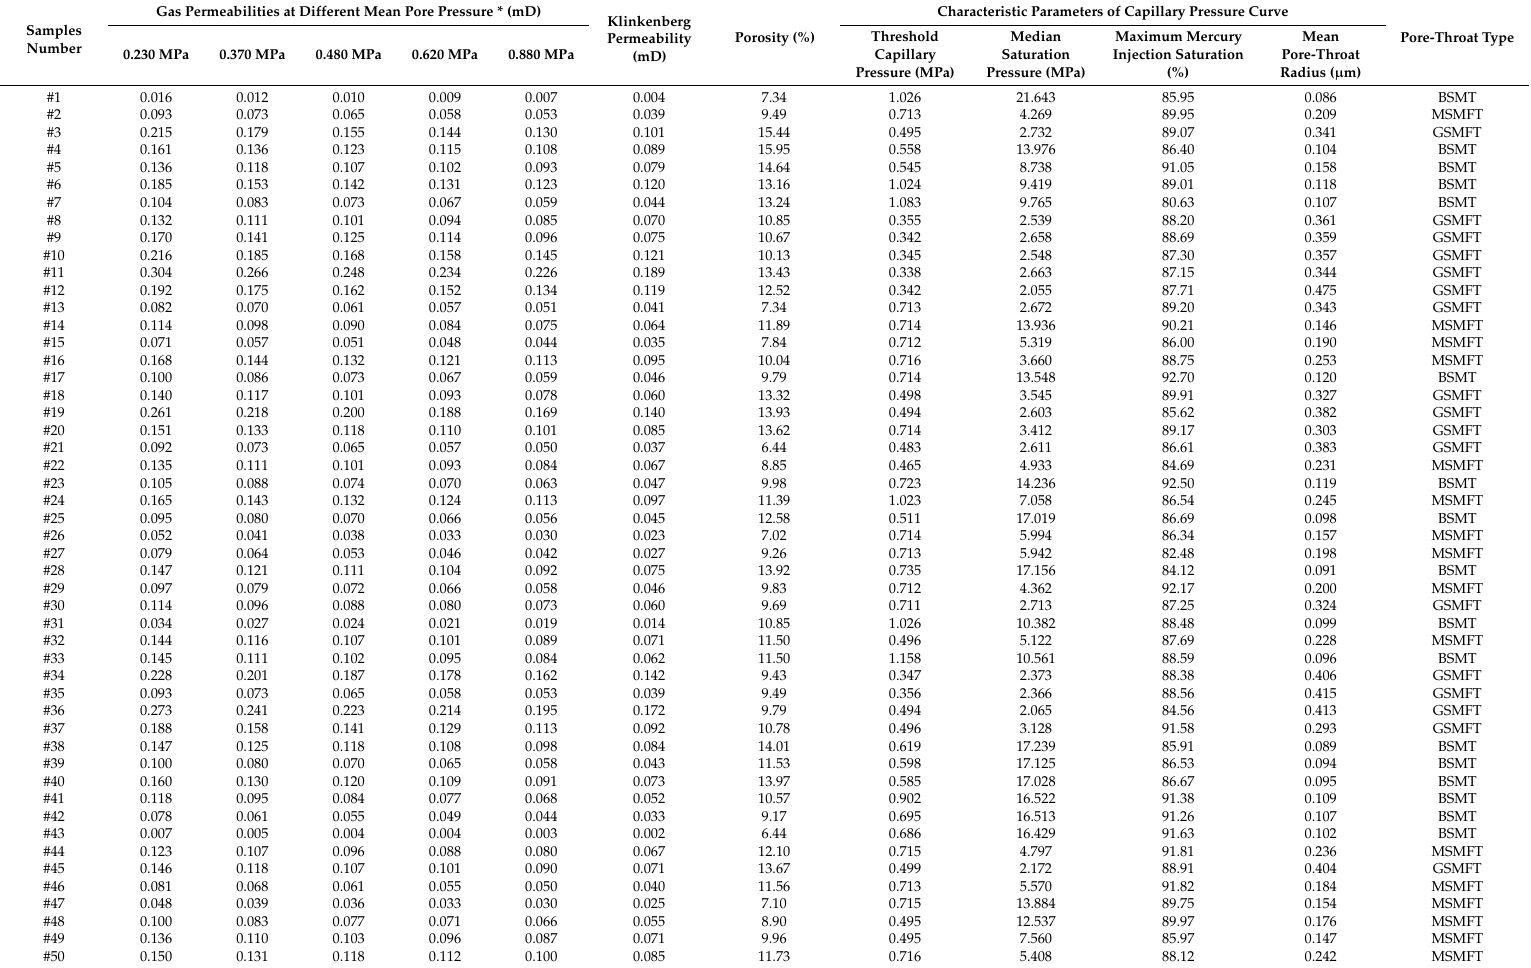
Table 1. Physical property and pore-throat structure parameters of core